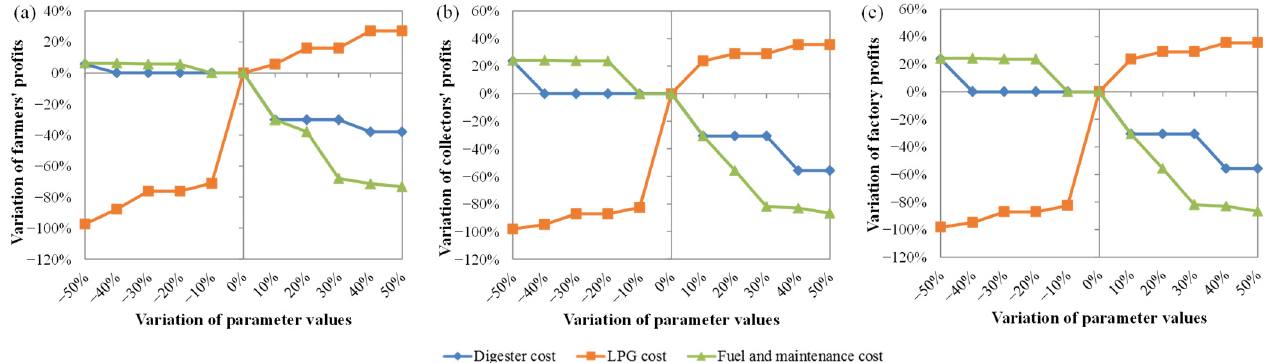
Figure 9. Sensitivity analysis of parameters on ( a ) farmers’ pro fi ts, ( b ) collectors’ pro fi ts, and ( c ) factory pro fi ts in scenario C2.